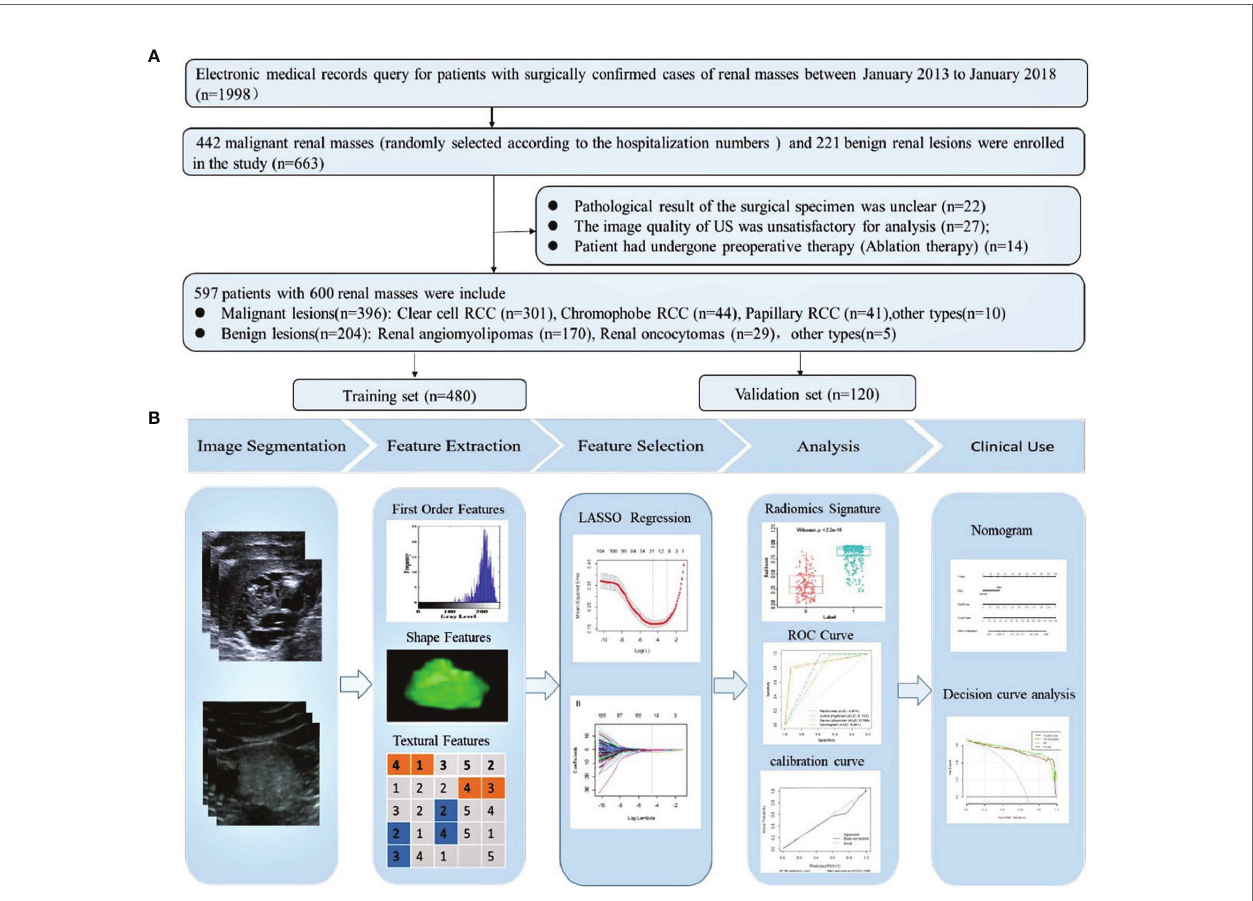
FIGURE 1 | (A) Flowchart of the inclusion, exclusion, and grouping criteria for patients with renal masses. One patient had three clear cell RCCs. One patient had two clear cell RCCs. RCC, renal cell carcinoma. (B) Flowchart of the radiomics analysis of renal masses.